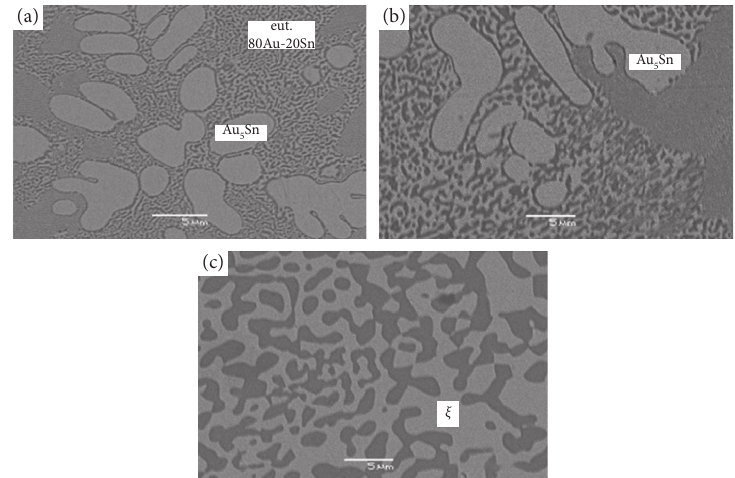
Figure 1: SEM-BSE micrographs of eutectic Au-Sn alloy depicting the phase transformations during thermal aging. (a) As-produced, (b) 150 ° C, 1 week, and (c) 200 ° C, 1 week [26].